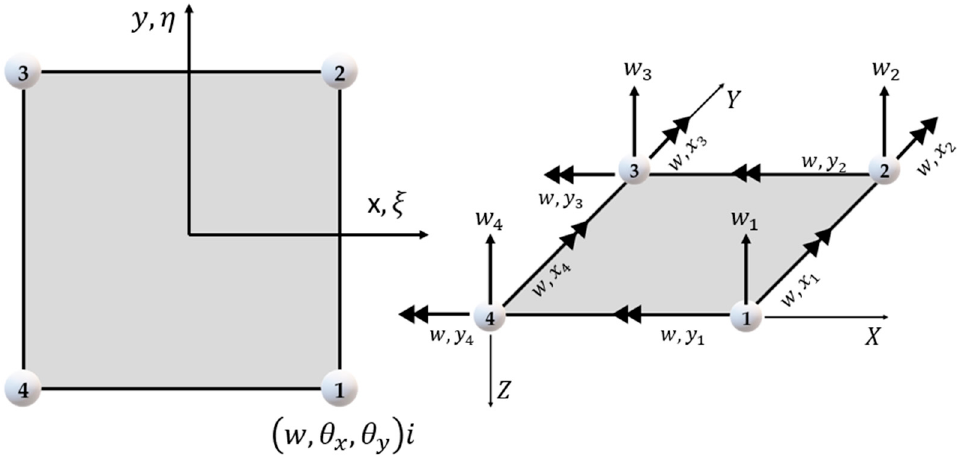
Figure 17. Rectangular plate element by Kirchhoff's theory.